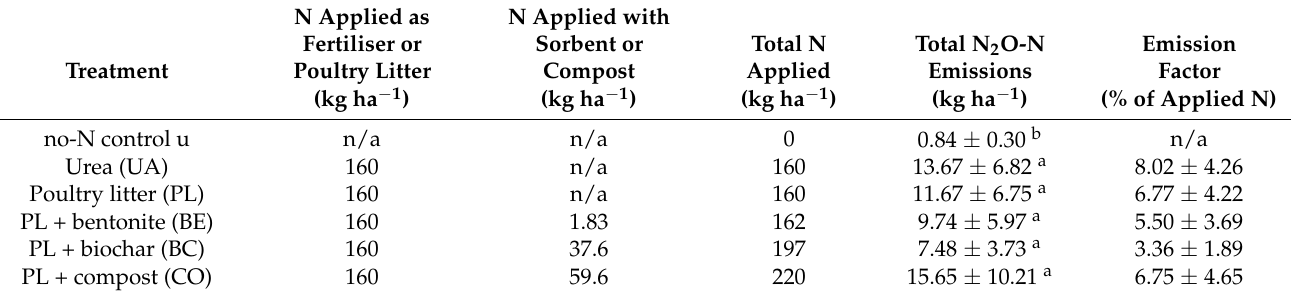
Table 2. Nitrogen application rates, total N 2 O emissions, and N 2 O emission factors from the N treatments tested at a commercial sugarcane farm. N 2 O emissions are mean ± SD of three replicates. Statistical analysis (one-way ANOVA with Fisher’s LSD post-hoc test) was carried out after log-transformation. Differences between treatments at p < 0.05 significance are indicated with different letters.